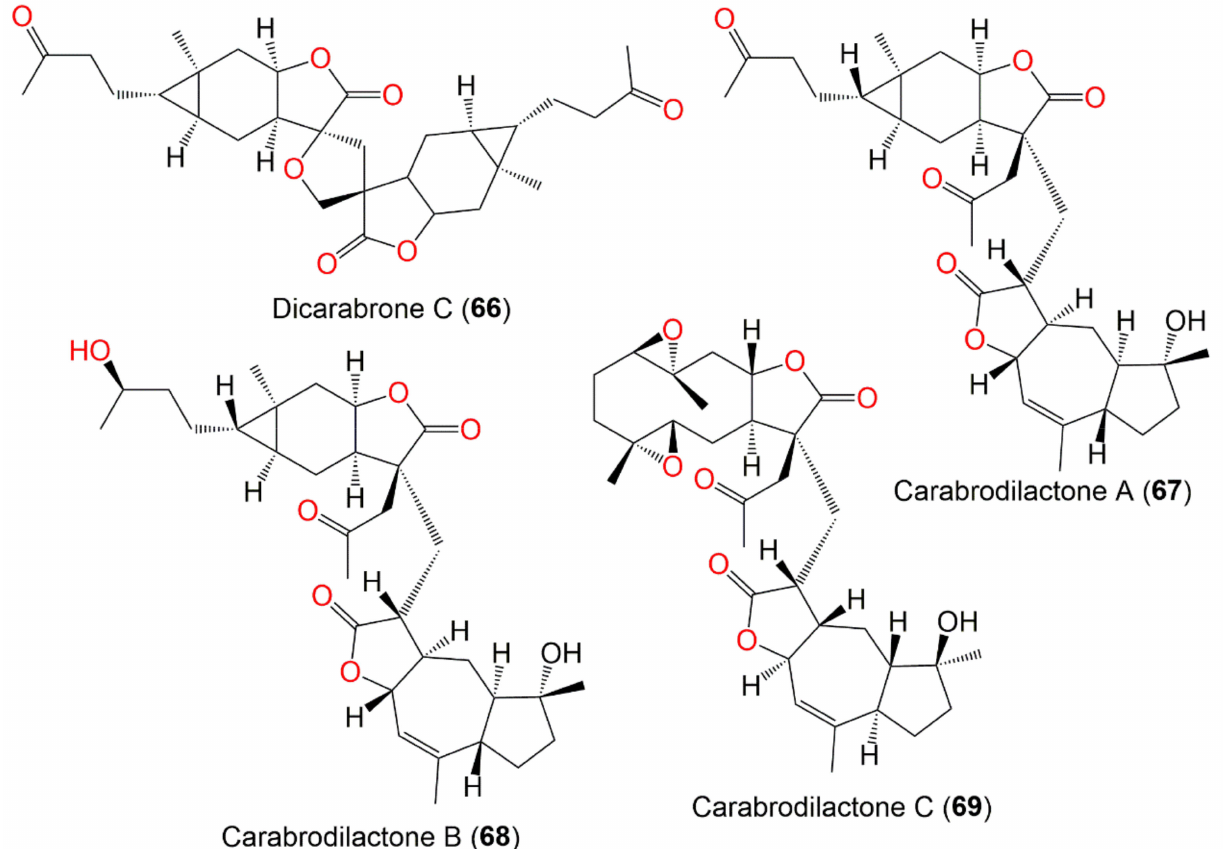
Figure 11. Dimeric sesquiterpenes ( 66 – 69 ) reported from C. abrotanoides . Biosynthetically, these C15/C17 metabolites were assumed to be generated through Stetter and Michael’s addition reactions. Firstly, the acetaldehyde anion is formed by umpolung of pyruvic acid through catalysis by thiamine. After that, it attacks the